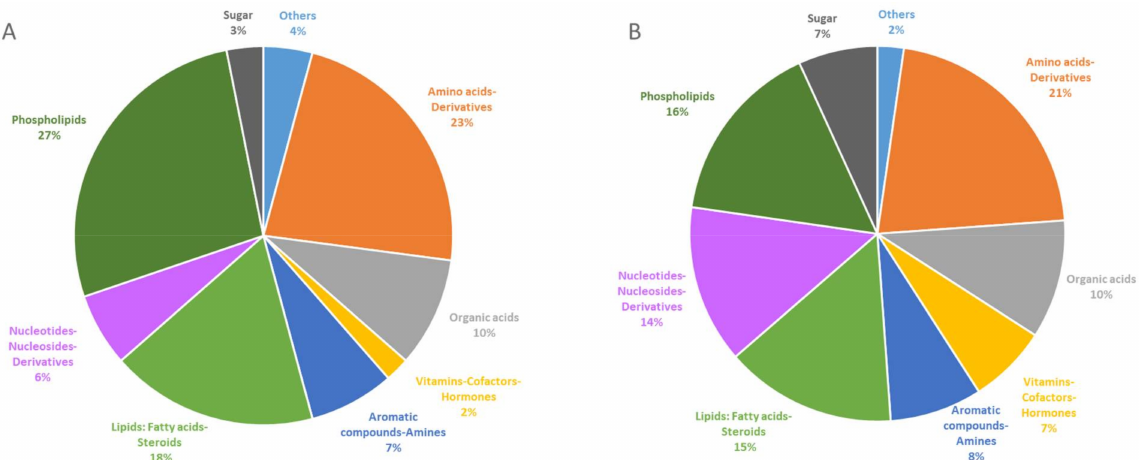
Figure 3. Pie chart visualization of chemical affiliation of metabolites in serum ( A ) and soleus ( B ). VIP metabolites, 96 from serum and 88 from soleus, were classified into nine different chemical classes: phospholipids in dark green, lipids: fatty acids—steroids in clear green, carbohydrate in black, amino acids-derivatives in orange, organic acids in grey, vitamins—cofactors–hormones in yellow, aromatic compounds—amines in dark blue, nucleotides—nucleosides derivatives in violet and others in clear blue. Results are given in the percentage of VIP belonging to the